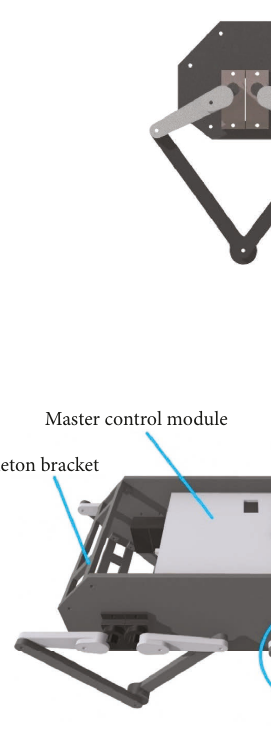
Figure 3: Small quadruped robot with a parallel leg mechanism.